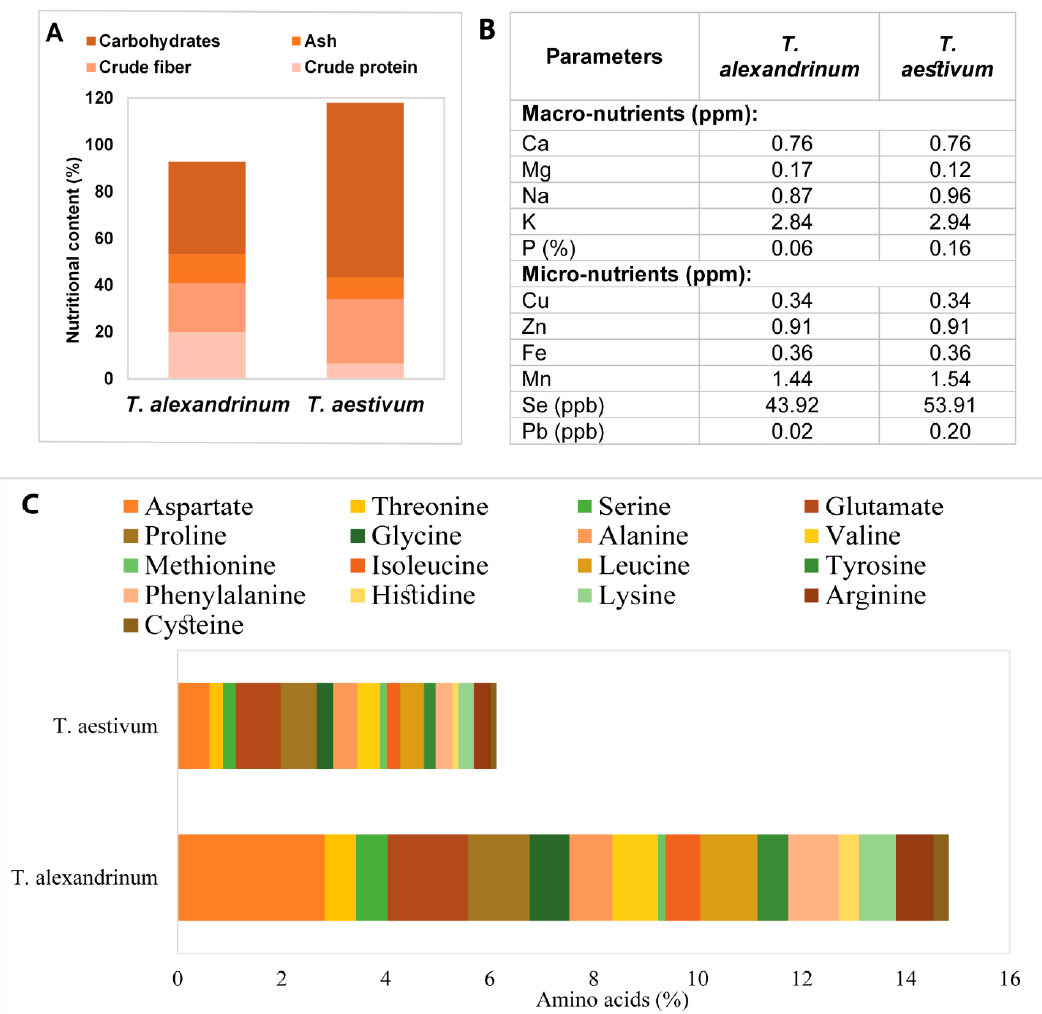
Figure 2. Nutritional profile of the dehydrated powders of Trifolium alexandrinum and Triticum aestivum : ( A ) Major contents of carbohydrates, proteins, fiber, and ash; ( B ) contents of macro- and micro-nutrients; and ( C ) contents of total and individual amino acids. Table 1. Analysis of variance (ANOVA) analysis of log CFU counts obtained for the endo-rhizosphere and endo-phyllosphere of wheat: The two-way interaction between tested culture media and incubation time is shown.